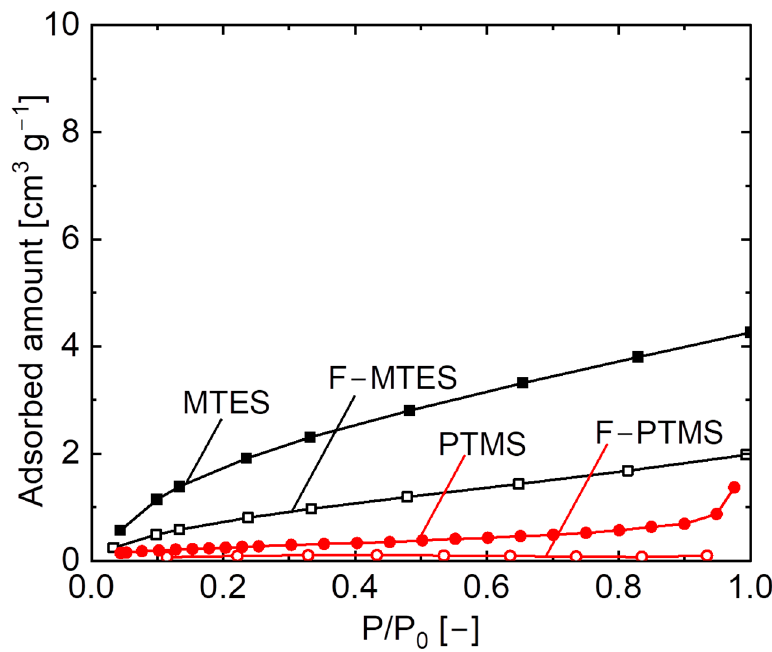
Figure 8. H 2 O adsorption isotherms at 25 °C for fluorine-doped (F–MTES, F–PTMS) and